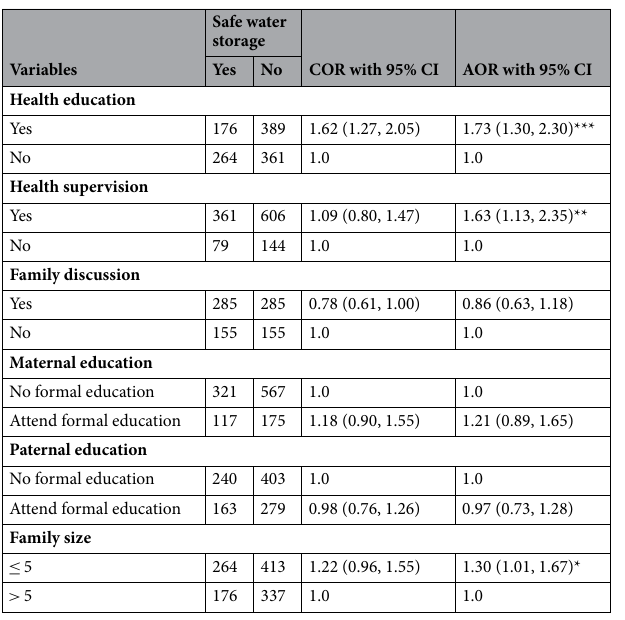
Table 5. Factors associated with safe water storage practice among households (n = 1190) in a rural setting of northwest Ethiopia, May 2016. AOR adjusted odds ratio, CI confidence interval, COR crude odds ratio. *Statistically significant at p < 0.05, **statistically significant at p < 0.01, ***statistically significant at p < 0.001, Hosmer and Lemeshow test = 0.219.